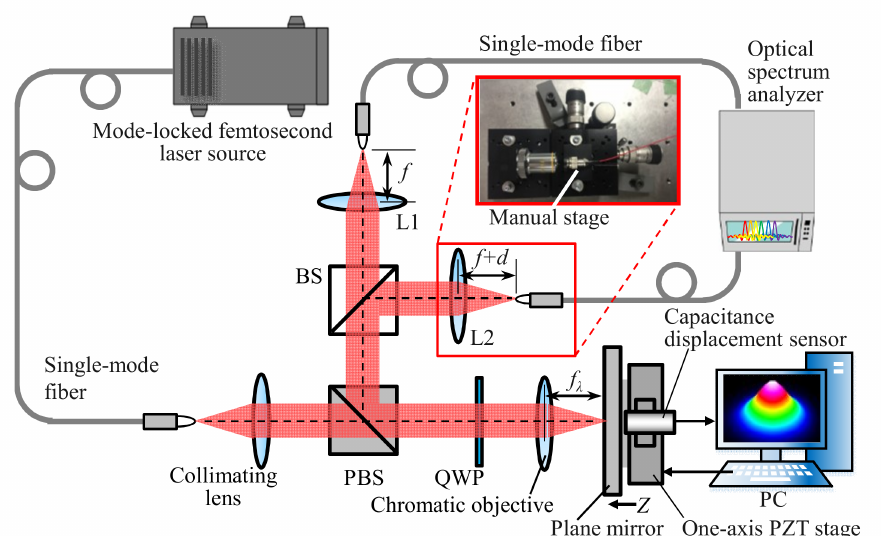
Figure 7. A schematic of the setup for the dual-detector chromatic confocal probe with a mode-locked femtosecond laser